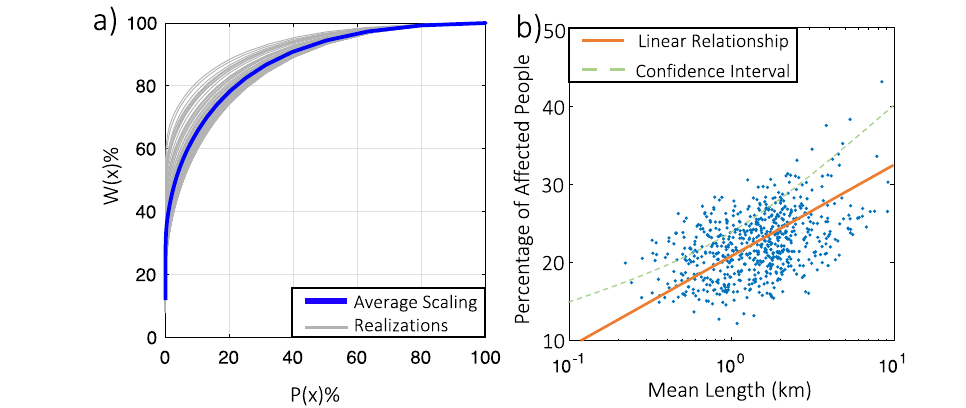
Fig. 5 | Network analysis of the synthetic TC-induced power outage in Harris County. a Generalized scaling law for the Harris power system: empirical prob- ability W(x) of a customer being affected by a disruption that affects more than x customers vs. empirical probability P(x) for a disruption to affect more than x customers during a storm event. The blue curve shows the average overall syn- thetic events in the historical simulation; the gray curves show randomly selected